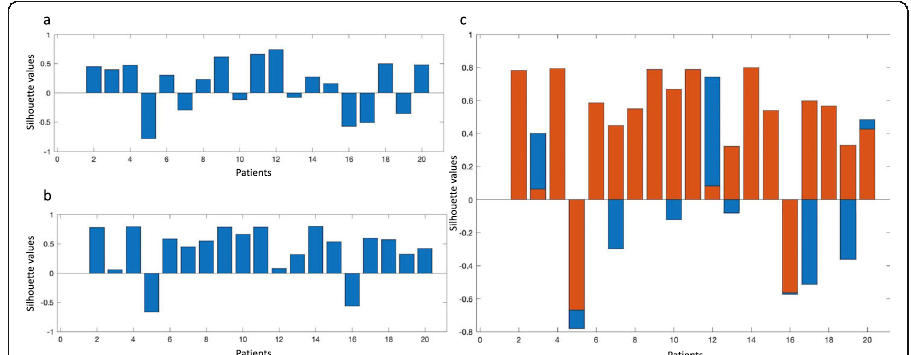
Fig. 5 Silhouette results among relapsing/refractory patients. Patient-wise silhouette among relapsing/